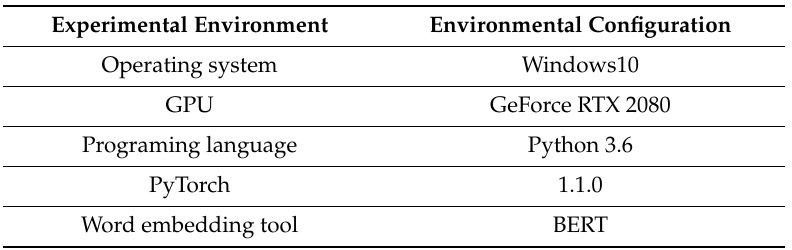
Table 2. Experimental